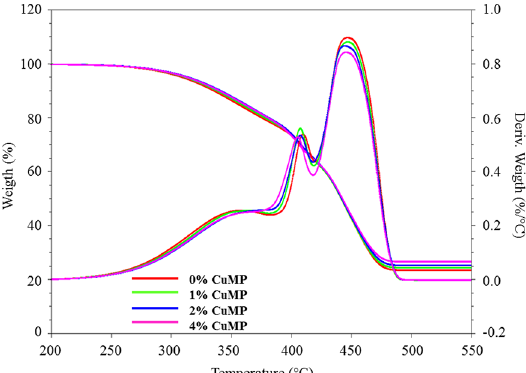
Figure 2. TGA and DTG curves of the